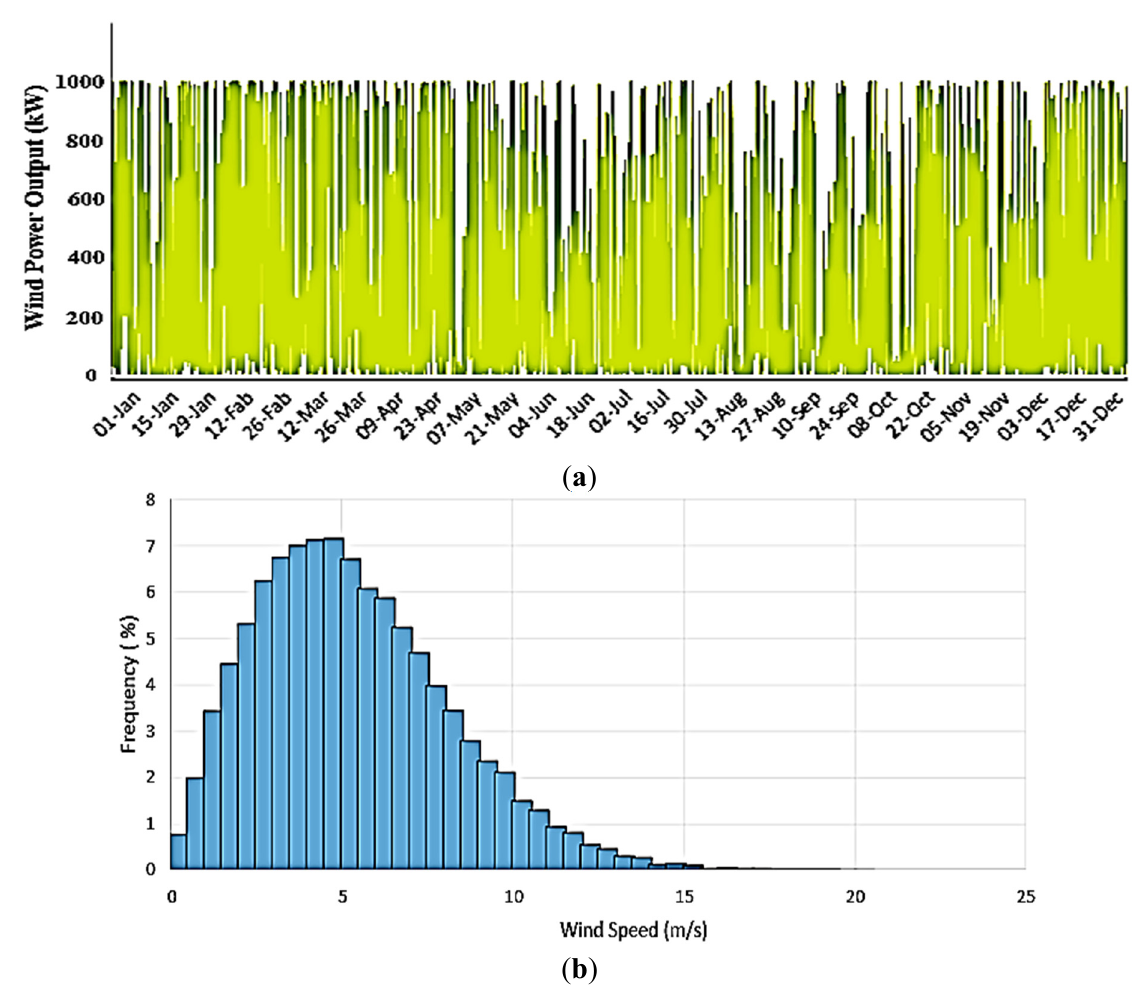
Figure 7. ( a ) The yearly wind turbine power output of the HRES for the proposed tourist village in the study; ( b ) Weibull probability distribution function of wind speed